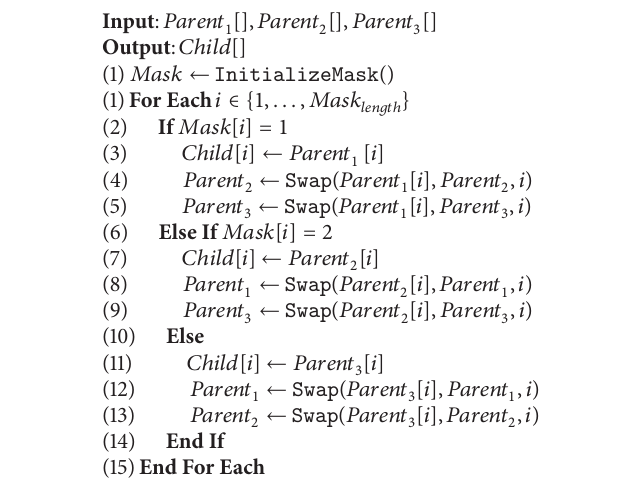
Algorithm 3: Multiparental sorting